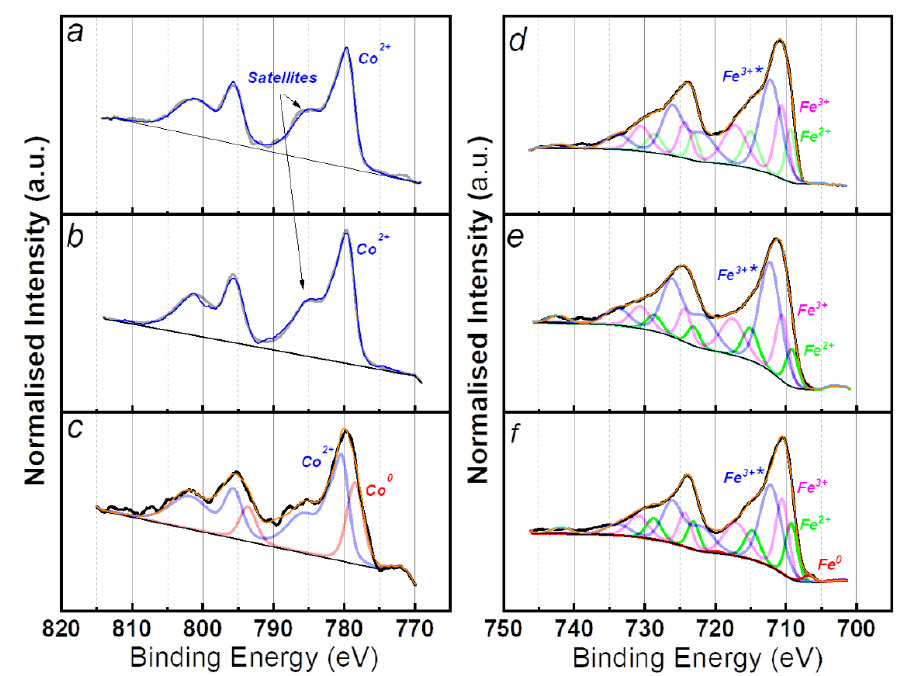
Figure 3. XPS spectra of Co (left) and Fe (right) catalysts after: ( a , d ) impregnation; ( b , e ) calcination; ( c , f ) reduction.